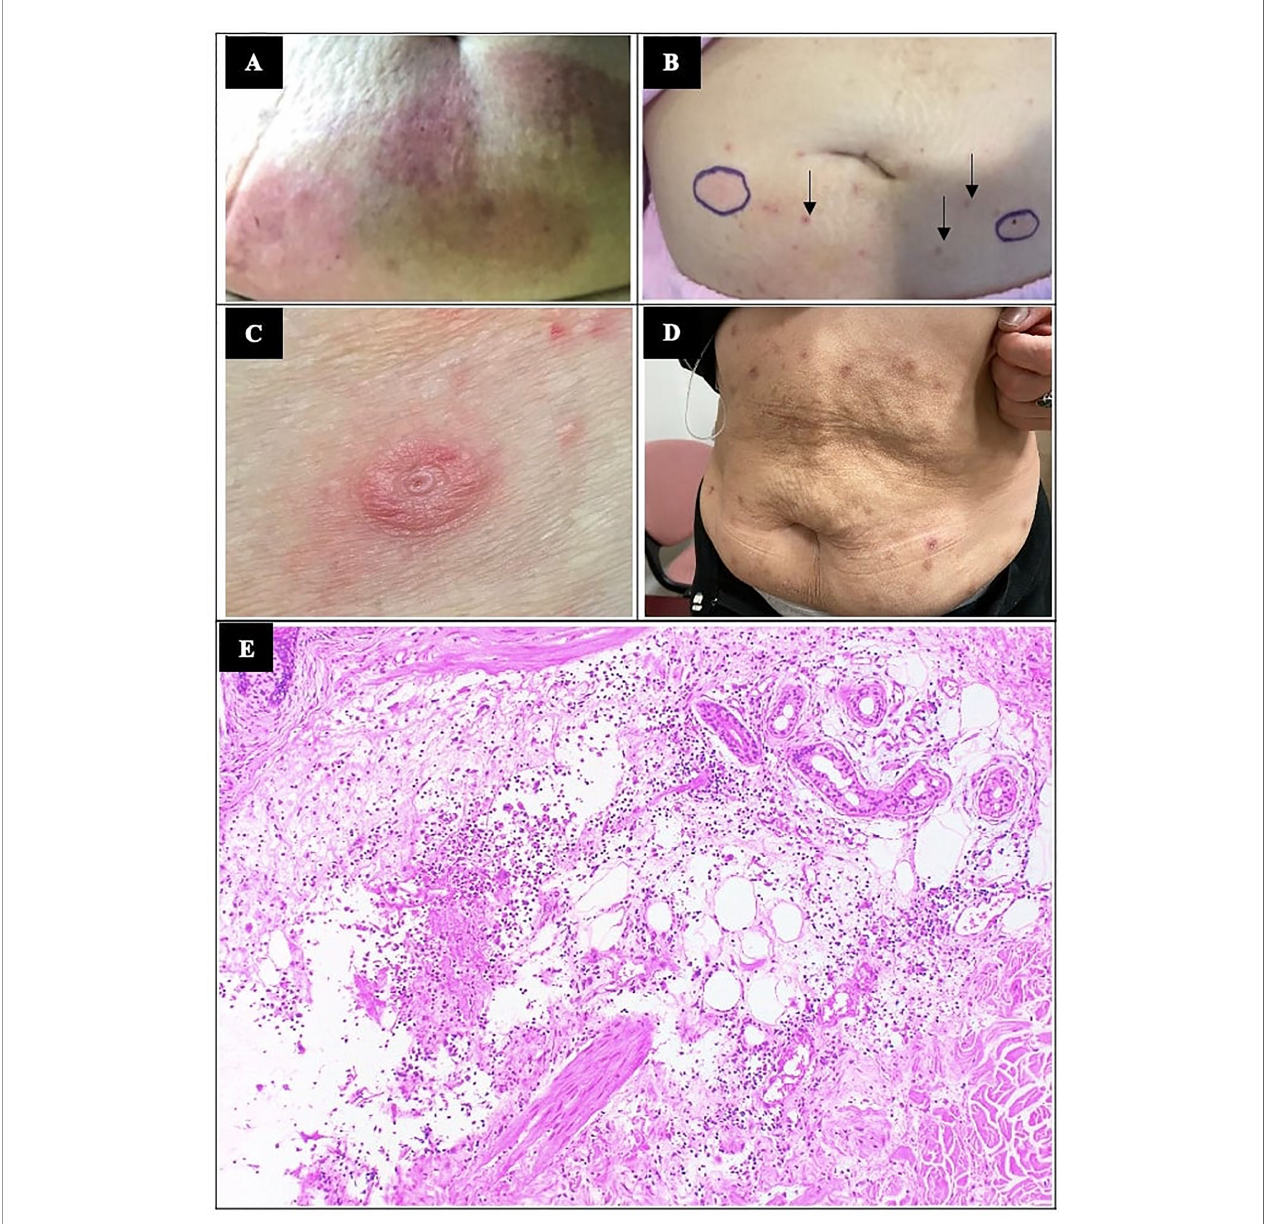
FIGURE 2 | Localised cutaneous hypersensitivity reactions to insulininjections. (A) Localised erythematous rashes at sites of insulin detemir injections at initial presentation. (B) Localised erythematous skin reactions occurred after test doses of glulisine, circled in blue. A few of the resolving rashes (small arrows) at previous insulin detemir sites at 3 days after hospital admission are shown. (C) Localised cutaneous reaction at insulin administration sites when patient was on insulin aspart (novorapid) subcutaneous insulin pump is shown here. Patch testing to consumables of insulin pump were negative. (D) Increasingly altered cosmesis of her abdominal skin from repeated localised allergic reactions to insulin were observed after 4 years of insulin therapy. (E) Histology by haematoxylin and eosin staining (x100 magni fi cation) showed dermal oedema and lymphohistiocytic perivascular in fl ammation suggestive of hypersensitivity